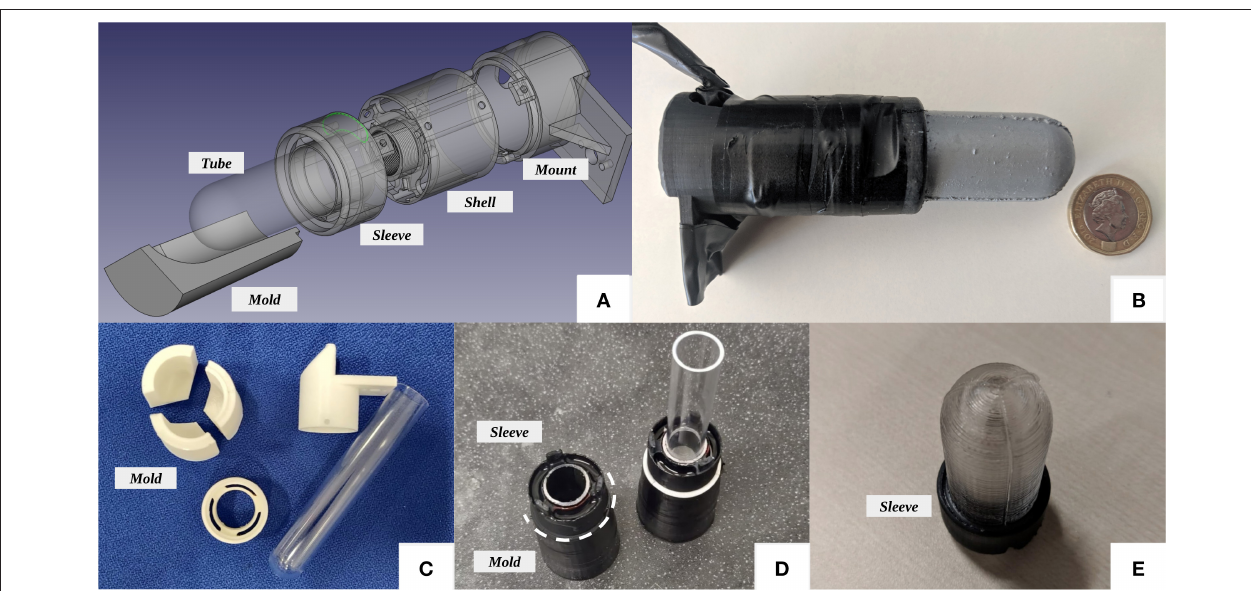
FIGURE 4 | (A) Exploded view of the GelTip tactile sensor design. (B) A GelTip sensor, next to a British one pound coin, for relative size comparison. The sensor has a length of approximately 10 cm , its shell has a diameter of 2.8cm, and the tactile membrane has a length of 4cm and a diameter of 2cm. (C) The three-part mold next to the remaining parts used in the GelTip construction. (D) The plastic tube is inserted into the sleeve and then mounted onto the mold, afterwards the tube is measured and trimmed and then the elastomer is poured. (E) The tactile membrane after being de-molded and before being painted.